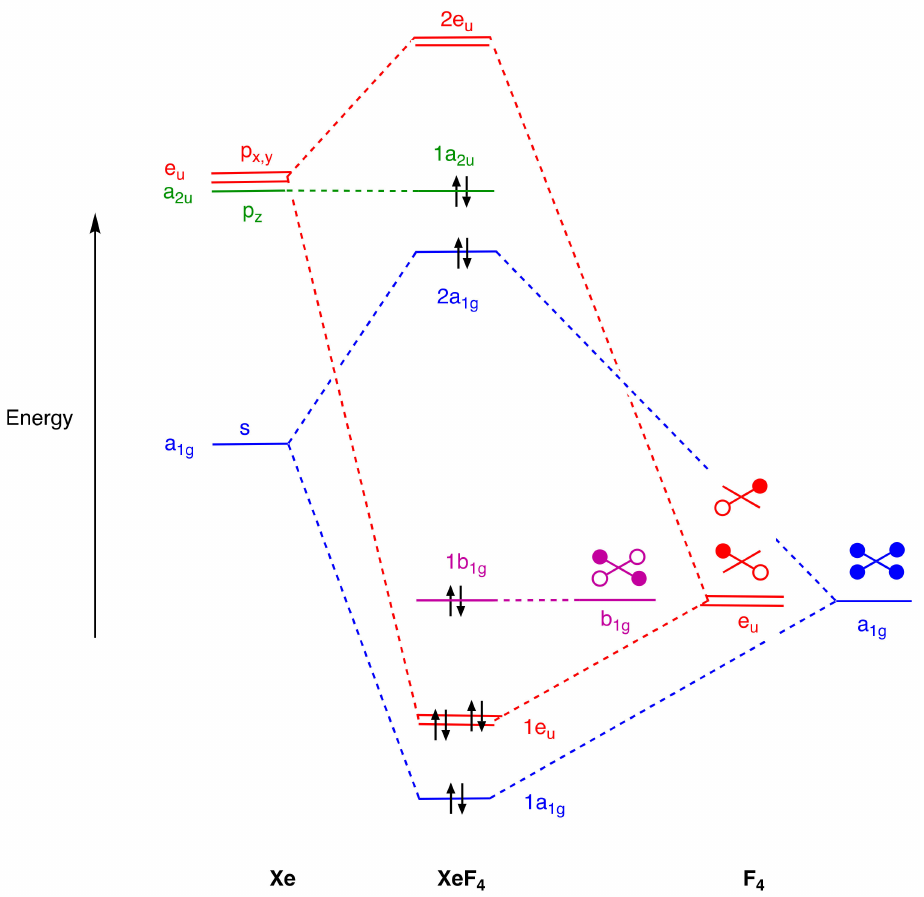
Figure 6. A simple, qualitative, σ -only MO energy-level diagram for XeF 4 . Orbital interactions involving the xenon 5s (a 1g ) and 5p x,y (e u ) orbitals are shown in blue and red, respectively. Orbital 1a 2u (iodine 5p z ), shown in green, and the fluorine-based orbital 1b 1g , shown in purple, are non- bonding by symmetry. Orbital 2a 1g is the antibonding counterpart of the 1a 1g bonding